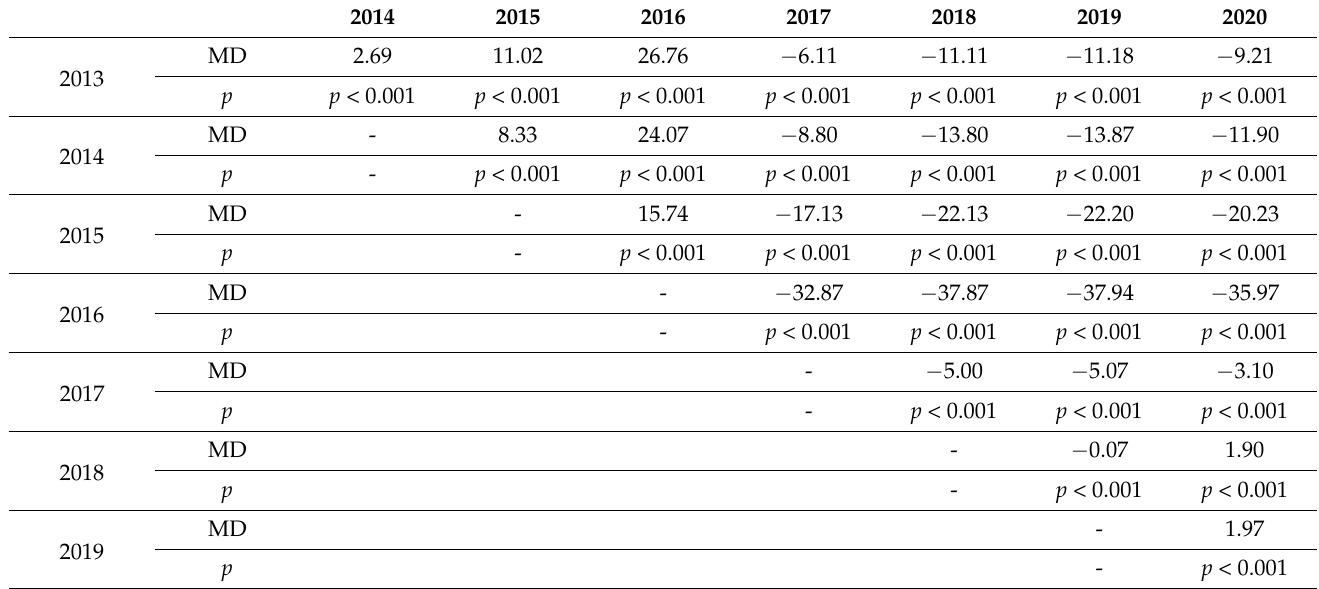
Table 10. Comparison of administering adrenaline at the correct time between individual editions of the Championships.